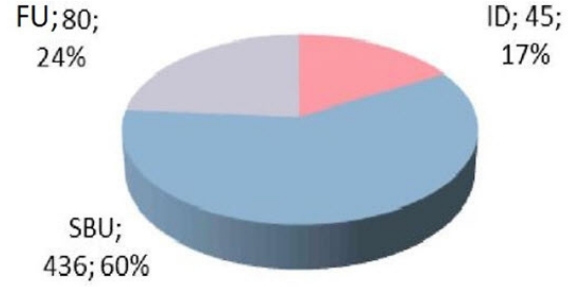
Figure 1. Percentage of errors in the categorisation of lexical units